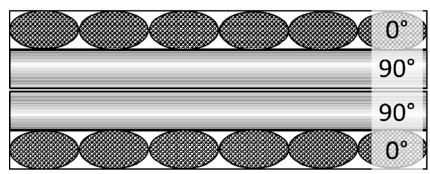
Figure 1. Schematic of the stack of each GFRP layer.